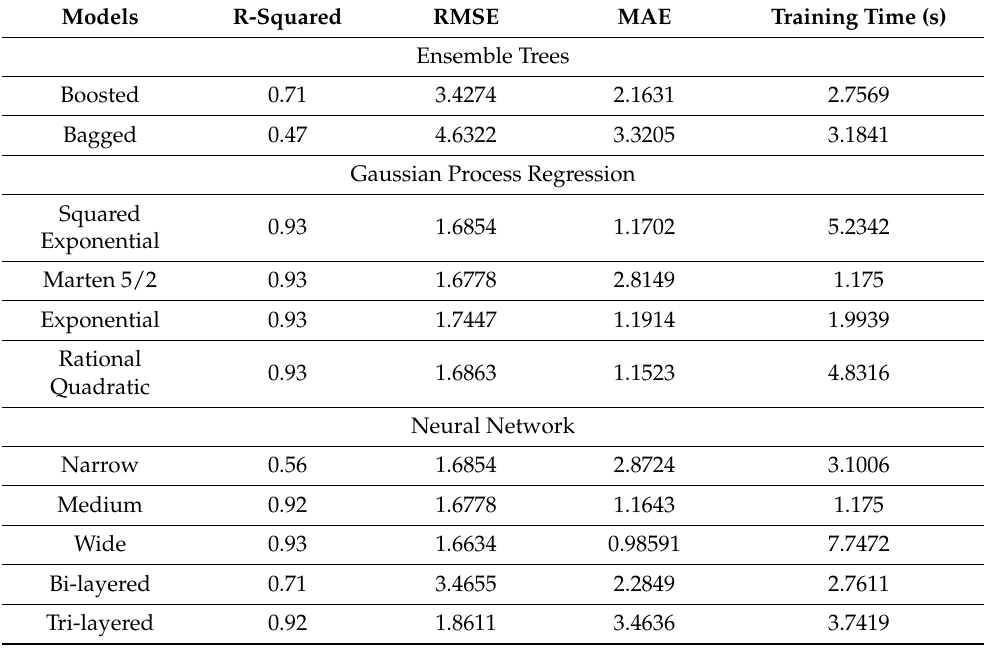
Table 5. Results comparison between ML